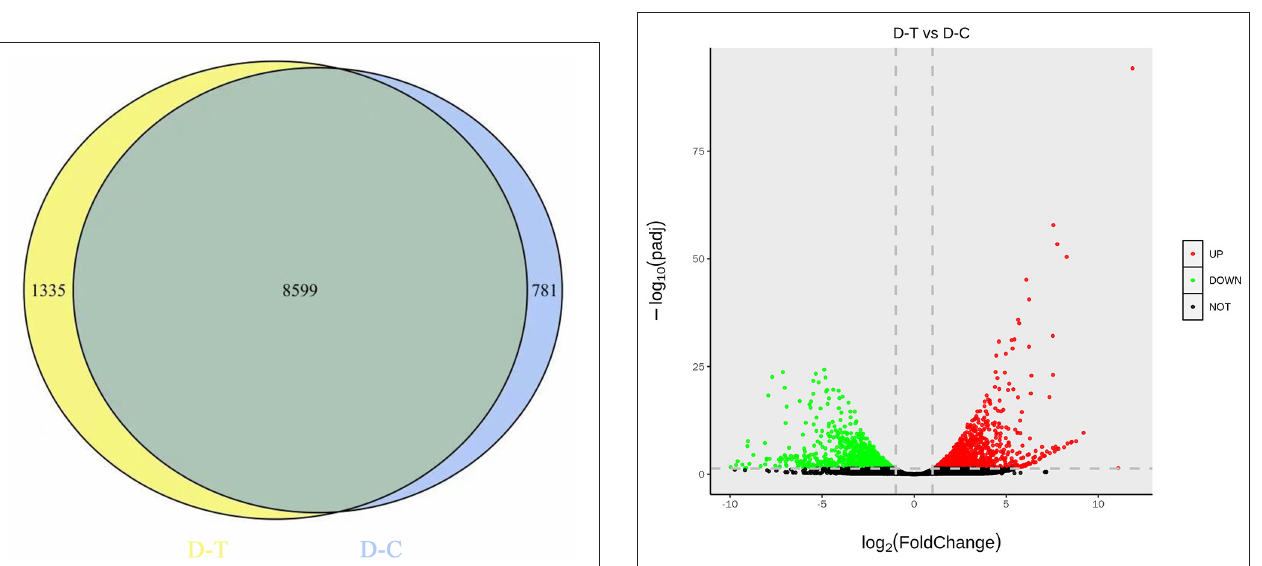
FIGURE 4 | The volcano of differentially expressed genes. The abscissa indicates gene expression in different treatments; the ordinate indicates the statistical significance of gene expression. The scatter in the graph represents each gene, the black dot represents the gene with no significant difference, the red dot represents the upregulated gene with a significant difference, and the green dot represents the downregulated gene with a significant